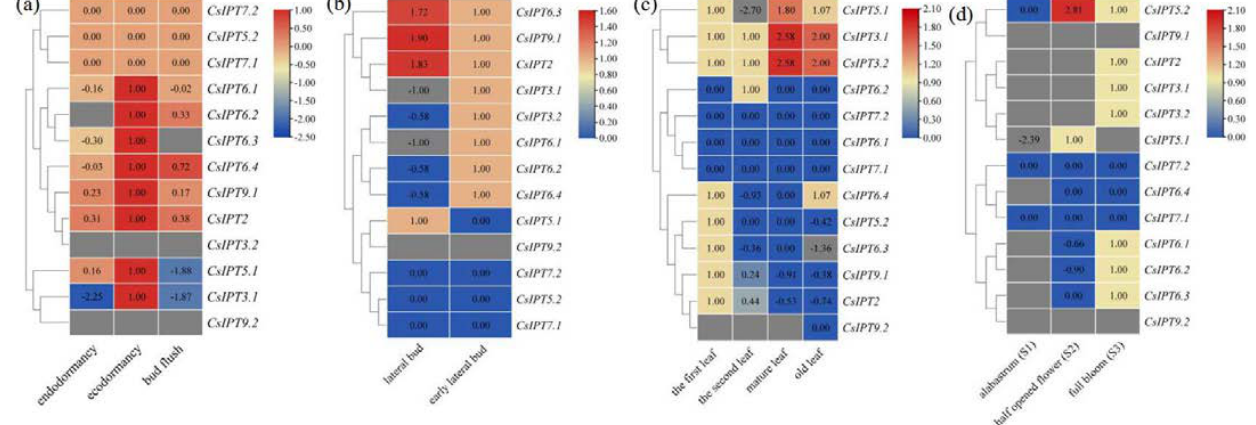
Figure 5. Expression profiles of CsIPT genes in different development stages of tea plants. ( a ) The expression profiles of CsIPTs during the stages from endodormancy to bud flush of lateral buds. ( b ) The expression profiles of CsIPTs during the process of lateral bud development. ( c ) The expression profiles of CsIPTs during the process of leaf development and senescence. ( d ) The expression profiles of CsIPTs during the process of flower development.